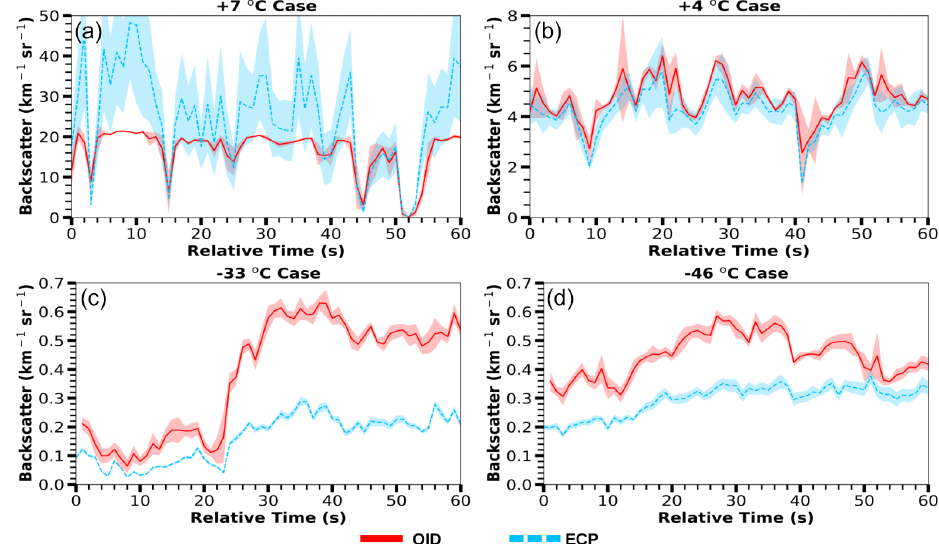
Figure 5. Plots showing 1Hz time series for the four case study segments (Table 2). Note the differing backscatter coefficient scales for the warm cloud cases. The external cloud probes (ECP) shadowed range is the measurement uncertainty determined from Eq. (7) and represents 1 standard deviation. The Optical Ice Detector (OID) shadowed range is 1Hz data representing 1 standard deviation computed from the 5Hz measurements. The ECP backscatter coefficient is obtained from particle data processed with the area-equivalent method.